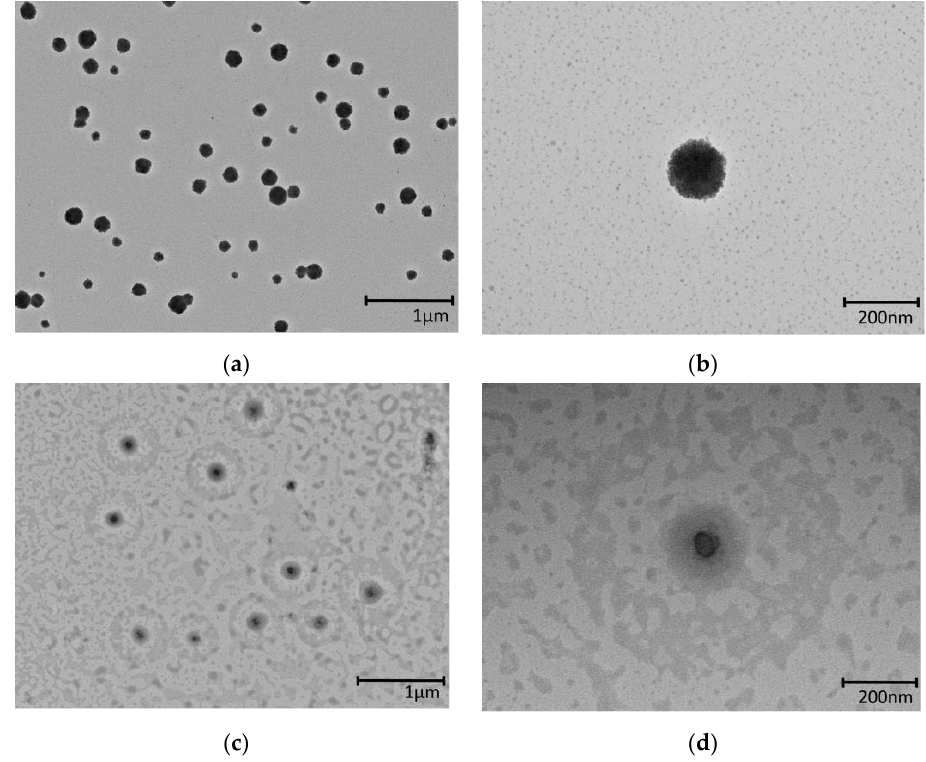
Figure 8. TEM images of TE-NEs ( a , b ) and WCS-TE-NEs ( c , d ) at a magnification of × 7000 for ( a , c ) and × 30,000 for ( b , d